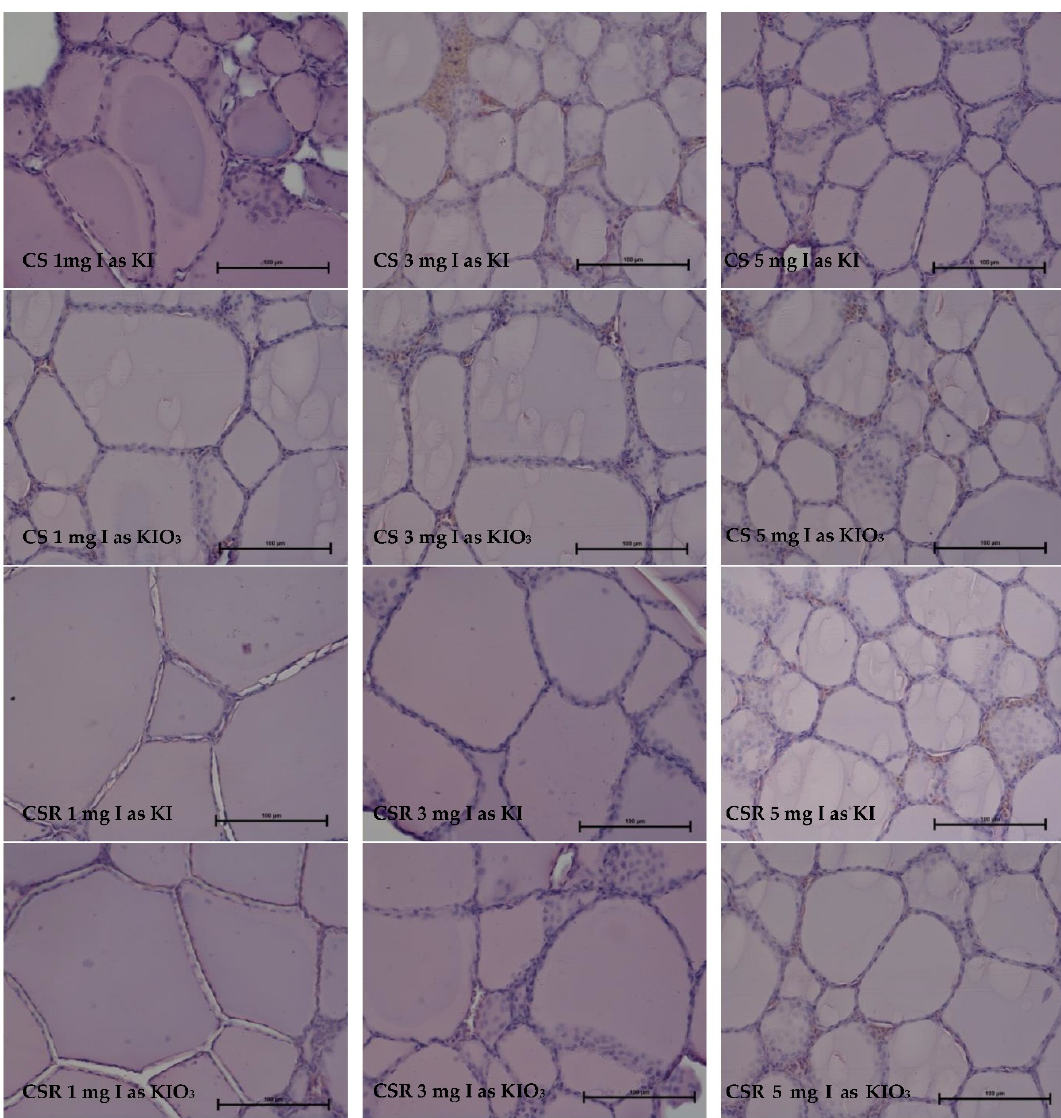
Figure 2. Representative pictures of the thyroid gland from the birds fed different diets, with different iodine supplements and levels (HiE Mag 400) (Experiment II).